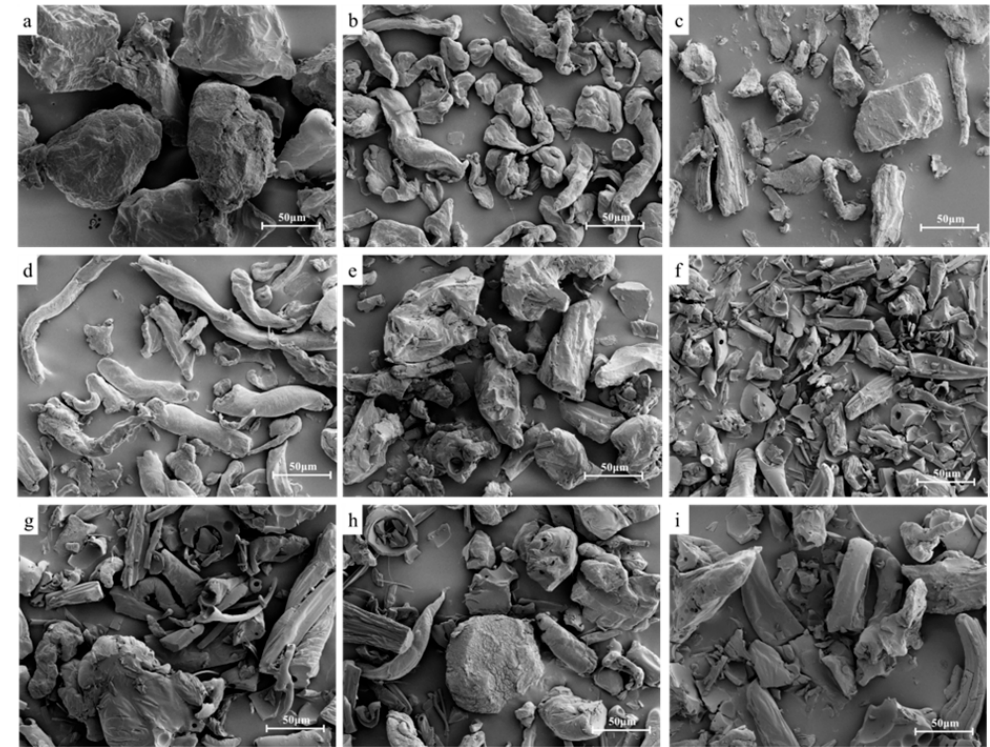
Figure 15. SEM image of thickeners and thickening components based on KGM for special medical use: ( a ) KGM; ( b ) GG; ( c ) XG; ( d ) LBG; ( e ) KC; ( f ) maltodextrin; ( g ) 1# thickening component; ( h ) 2# thickening component; ( i ) 3# thickening component.